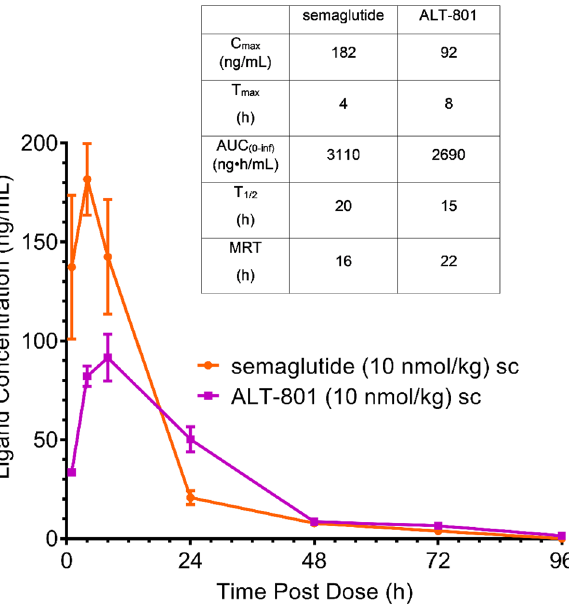
Figure 1. Pharmacokinetic behavior of ALT-801 and semaglutide in C57Bl/6J mice following subcutaneous administration. Mice received a single s.c. injection of ALT-801 or semaglutide at 10 nmol/kg and key PK characteristics were calculated. Compared to semaglutide, for ALT-801 the data indicate a longer T max with a substantially lower C max and an overall delayed PK envelope, having a similar